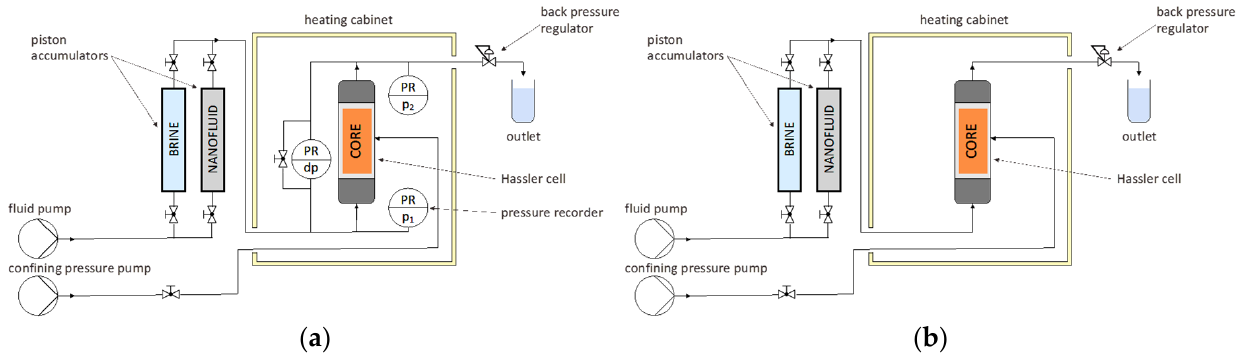
Figure 4. Core flooding setups used in this work for ( a ) permeability measurements and for ( b ) effluent analysis (nano single-phase floods) purposes. The core holder was placed vertically inside a heating cabinet, and in ( a ), pressure sensors were fitted to record the pressure differential across the core. In ( b ), fluid samples were collected after being injected into the rock at 60 °C. In both cases, a confining pressure of 35 bar was used.